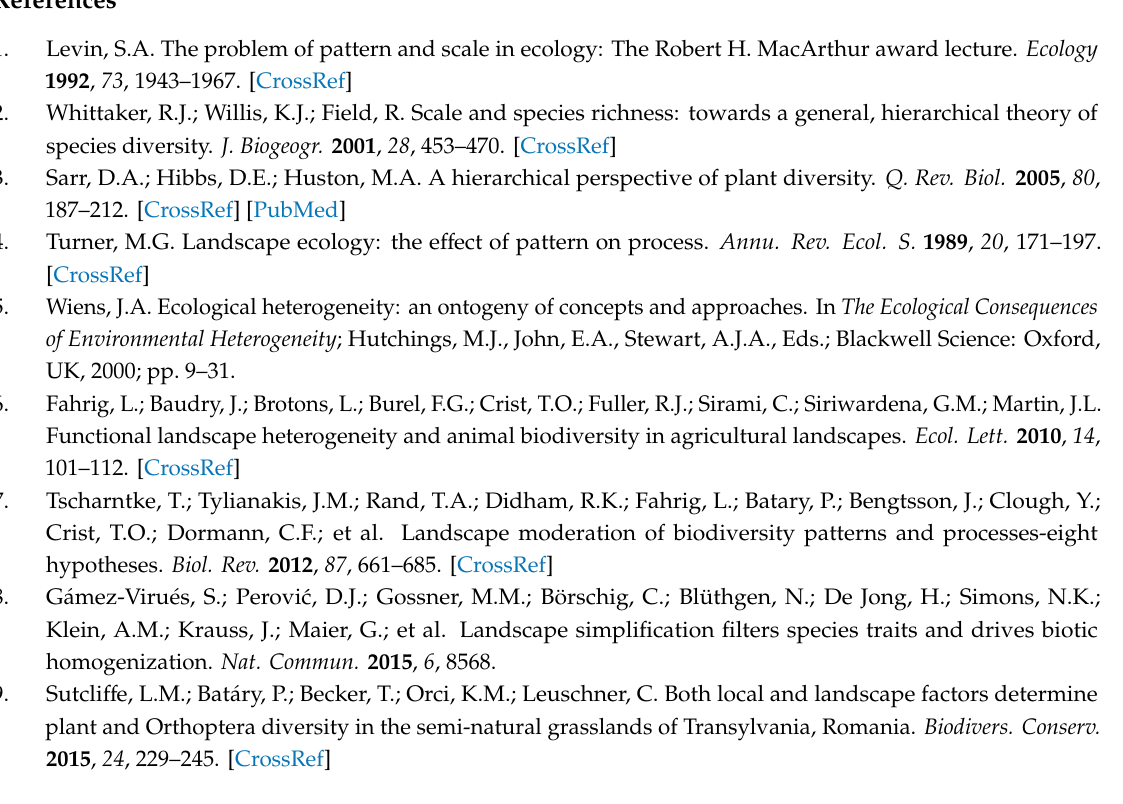
Table S1. Sum of microquadrats (a) and sites (b) considering the two main e ff ects of landscape heterogeneity, gap / forest environment and their interaction. Figure S1. Box-plot of the multivariate distance to the spatial mean (centroid) for shrub (a to d) and tree seedling (e to h) species groups in landscapes of di ff erent heterogeneity levels (heterogeneous (Het), moderate (Mod), homogenous (Hom)) for di ff erent gap / forest environments (forest (F) understory, small (S) gaps, medium (M) gaps, large (L) gaps). Figure S2. Species rarefaction curves from landscapes with di ff erent spatial heterogeneity levels (heterogeneous (Het), moderate (Mod), homogenous (Hom)) in four distinct gap / forest environments (forest (F) understory, small (S) gaps, medium (M) gaps, large (L) gaps) for shrub ( a to d ) and tree seedling ( e to h ) species. Figure S3. Species rarefaction curves from four distinct gap / forest environments (forest (F) understory, small (S) gaps, medium (M) gaps, large (L) gaps) for shrub ( a ) and tree seedling ( b )